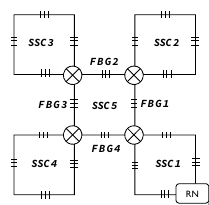
Figure 14. FBG distribution in